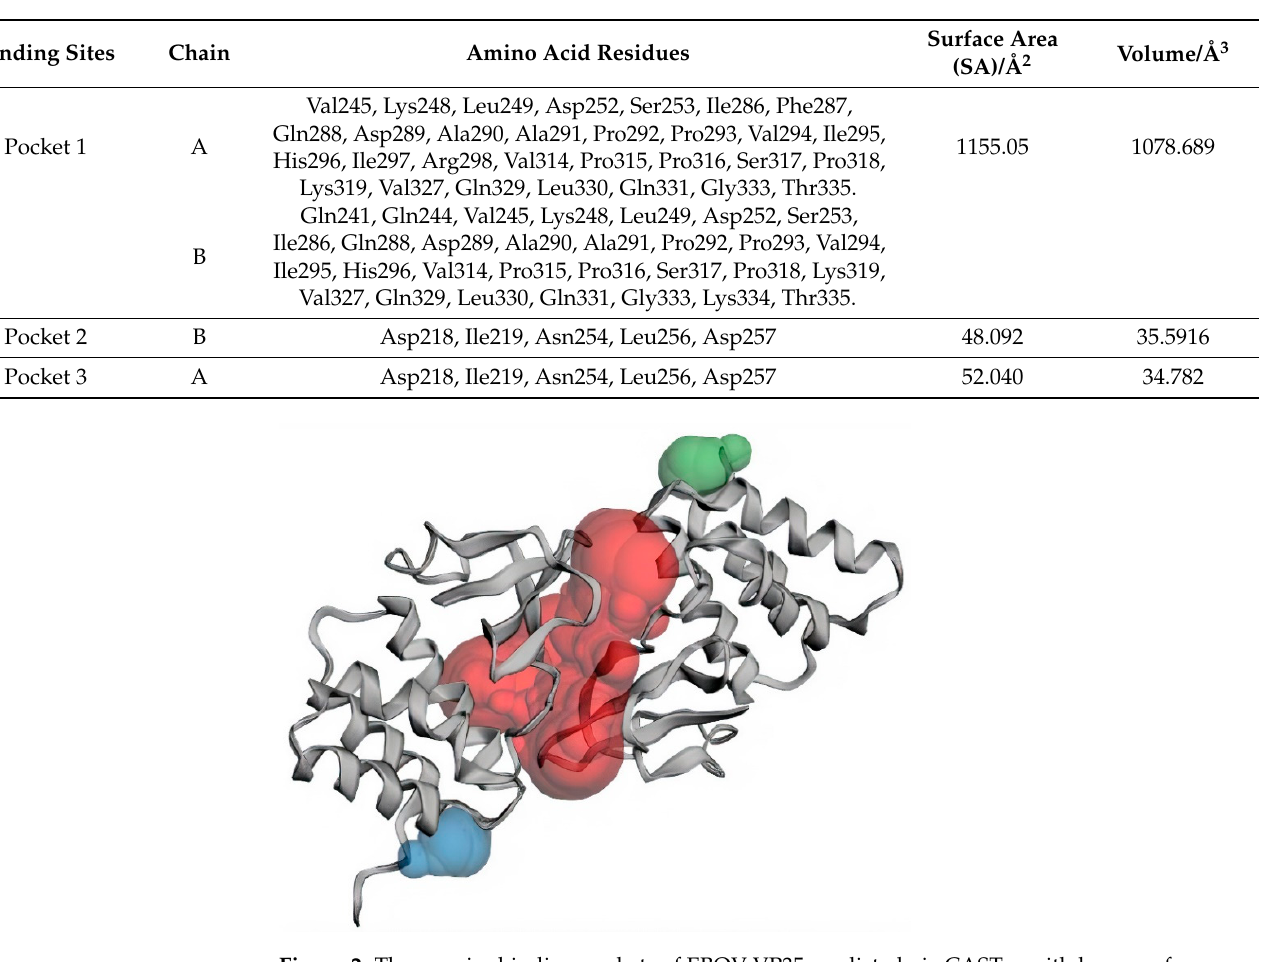
Table 1. Major binding sites of EBOV VP35 predicted using CASTp and the amino acid residues within each binding pocket. SA: Solvent accessible.